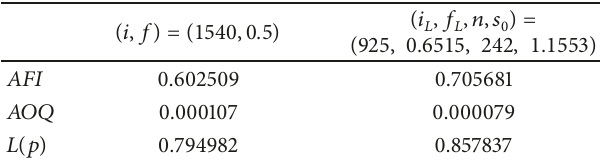
Table 7: Comparison of the performances of 𝐴𝐹𝐼 , 𝐴𝑂𝑄 , and 𝐿(𝑝) . (𝑖, 𝑓) =